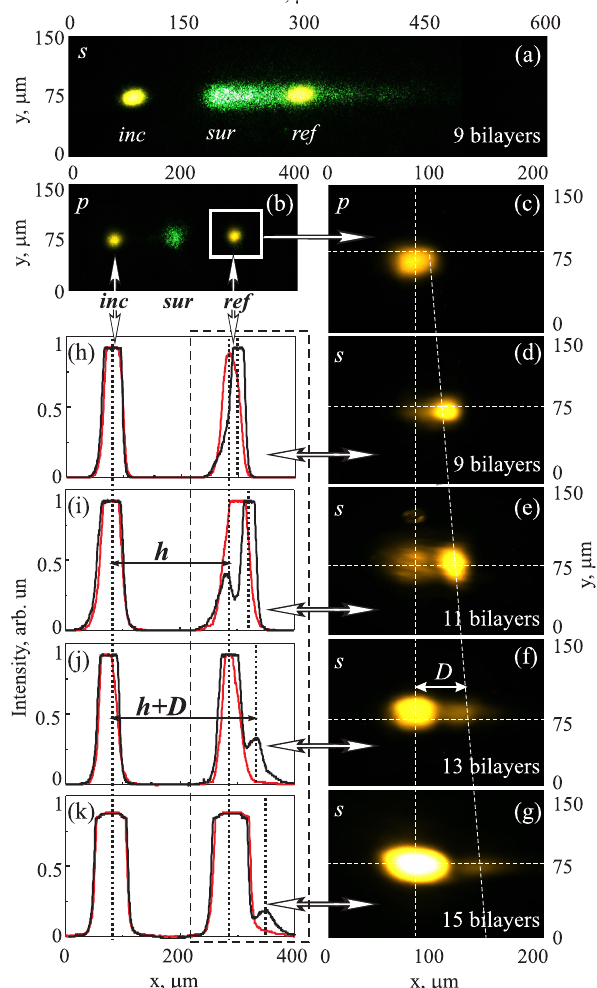
Figure 7. Microimages of the surface of the photonic crystal illuminated with s - ( a ) and p -polarized ( b ) light; The objective lens is focused on the photonic crystal surface; ( c ) Fluorescence microimage of the reflected p -polarized beam. The objective is focused in the immersion liquid layer; ( d – g ) Fluorescence microimages of the s -polarized beam reflected from photonic crystals with different numbers of bilayers. The Goos–Hänchen shift is marked as D; ( h – k ) Fluorescence intensity profiles of s - (black line) and p -polarized (red line) beams. Left and right peaks correspond to incident (inc) and reflected (ref) spots. Reprinted with permission from I.V. Soboleva, V.V. Moskalenko, A.A. Fedyanin, Phys. Rev. Lett. 108, 123901 (2012). Copyright (2012) by the American Physical Society